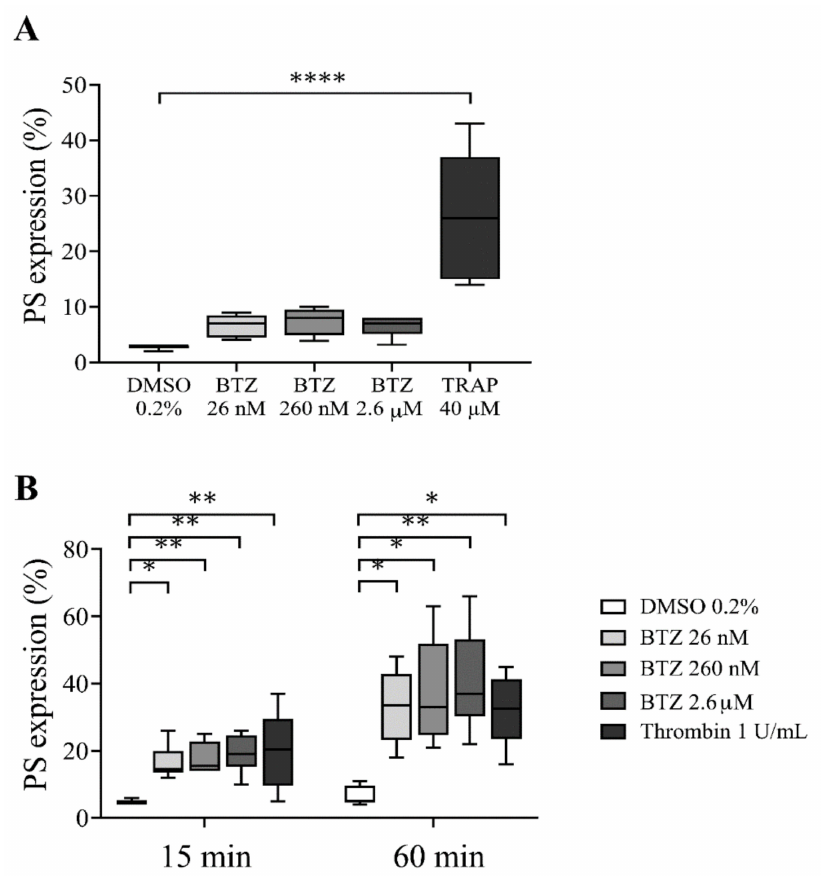
Figure 1. PS expression in BTZ-pretreated human PRP and GFPs. In panel ( A ), the PRP of healthy subjects was treated with BTZ, TRAP (positive control) and DMSO (negative control) for 60 min. In panel ( B ), platelets were isolated from the PRP of healthy subjects by gel-filtration and treated with BTZ, thrombin (positive control) and DMSO (negative control) for 15 and 60 min. PS expression was measured by flow cytometry based on CD41 and annexin V double positivity. Data are expressed as median and interquartile range of 5 experiments for panel ( A ) and 6 experiments for panel ( B ). The level of significance in panel ( A ) was determined using the Kruskal–Wallis test and Dunn’s multiple comparisons test; **** p < 0.0001 compared to the DMSO group. In panel ( B ), the level of significance at 15 min of treatment was determined using ANOVA and Dunnett’s multiple comparisons test; * p < 0.05 and ** p < 0.01 compared to the DMSO group. The level of significance at 60 min of treatment was determined using Kruskal–Wallis test and Dunn’s multiple comparisons test; * p < 0.05 and ** p < 0.01 compared to the DMSO group. BTZ: bortezomib; DMSO: dimethyl sulfoxide; PS: phosphatidylserine; TRAP: thrombin receptor-activating